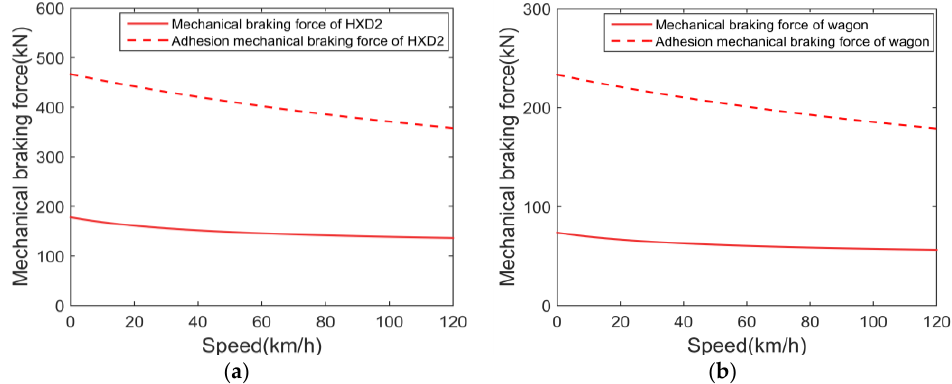
Figure 3. Mechanical braking force and adhesion force of a freight train: ( a ) locomotive; and ( b ) wagon.